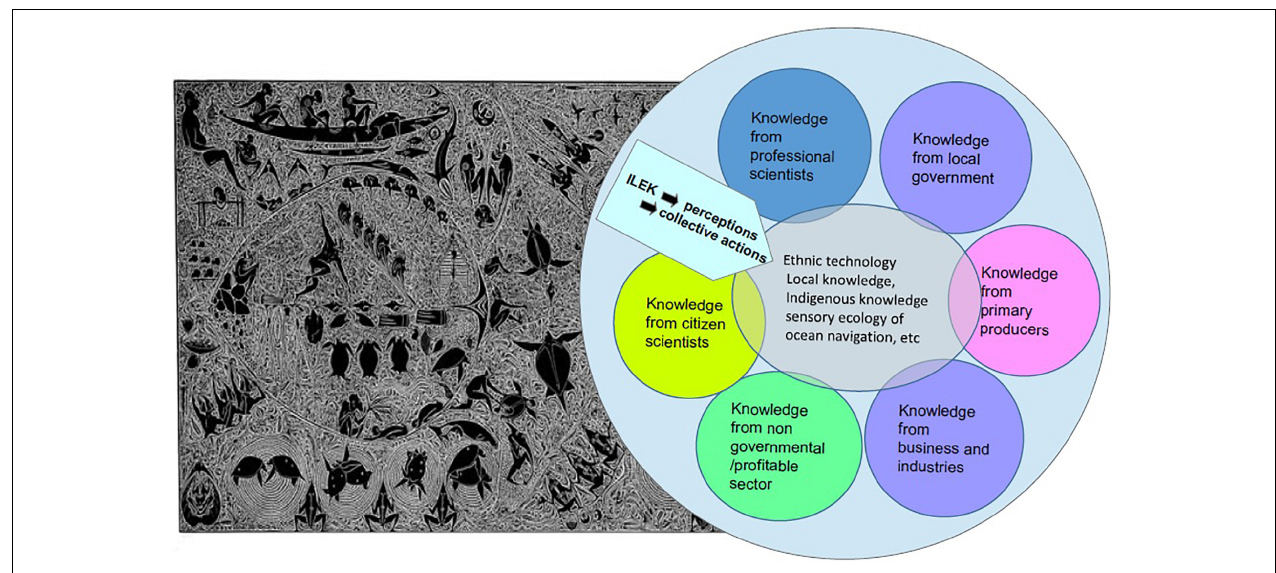
FIGURE 1 | Different perspectives of marine resource management in the Pacific Island States involving the concept of Integrated Local Environment Knowledge (ILEK). In the background, a linocut, “Wadth, Zigin Ar Kusikus,” made in 2005 by Alick Tipoti, an artist from Badu Island in the Torres Strait. © Alick Tipoti/www.artsdaustralie.com. It depicts an interpretation of the cycles of life at sea and the multi-faceted network between living species, humans, non-human entities and nature. On the right side, a conceptual diagram modified from Sato (2014) representing ILEK, integrating all stakeholders’ knowledge leading to perceptions and collective actions, a process used for adaptive societal transformation and social learning to achieve sustainable resource